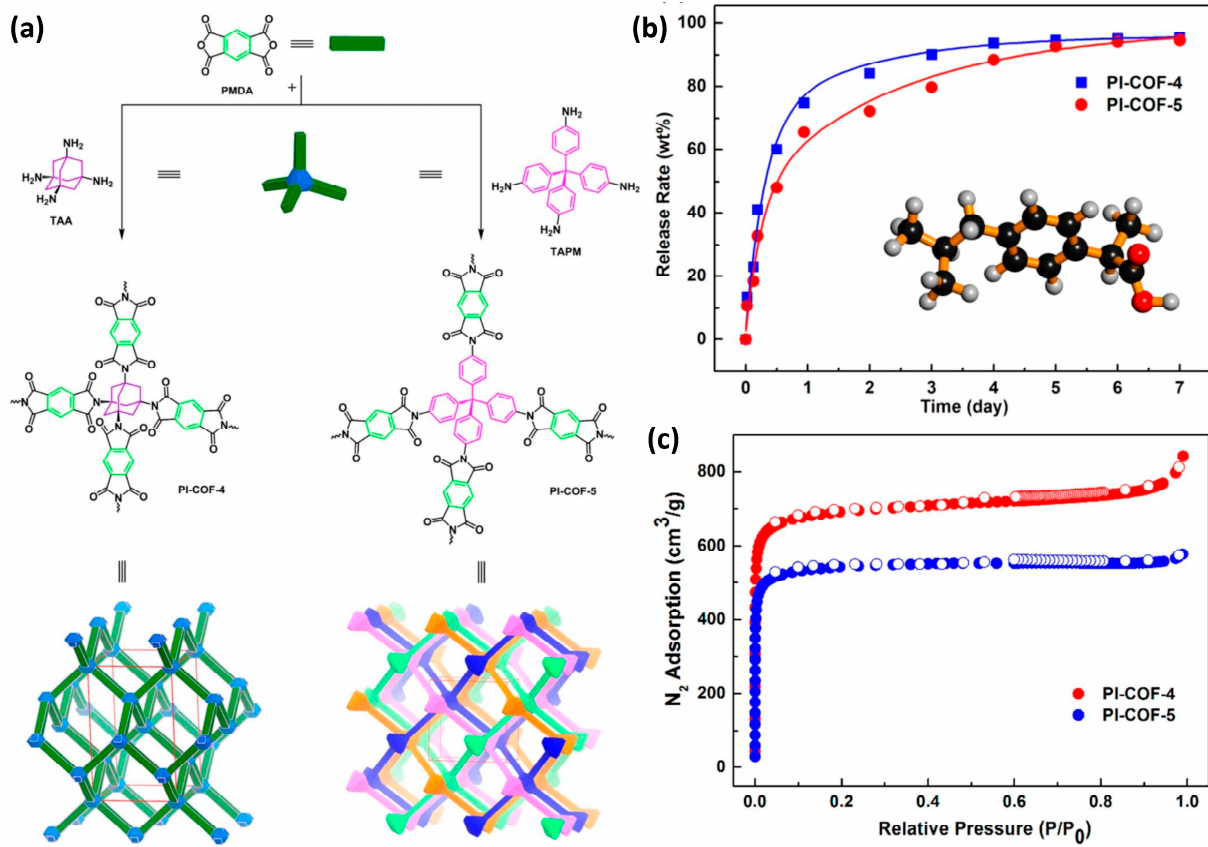
Figure 9. ( a ) Synthesis and structural representations, ( b ) BET surface area, and ( c ) drug release profile of PI-COF-4 and PI-COF-5 with ibuprofen (IBU) as a model drug release in a simulated body [33].